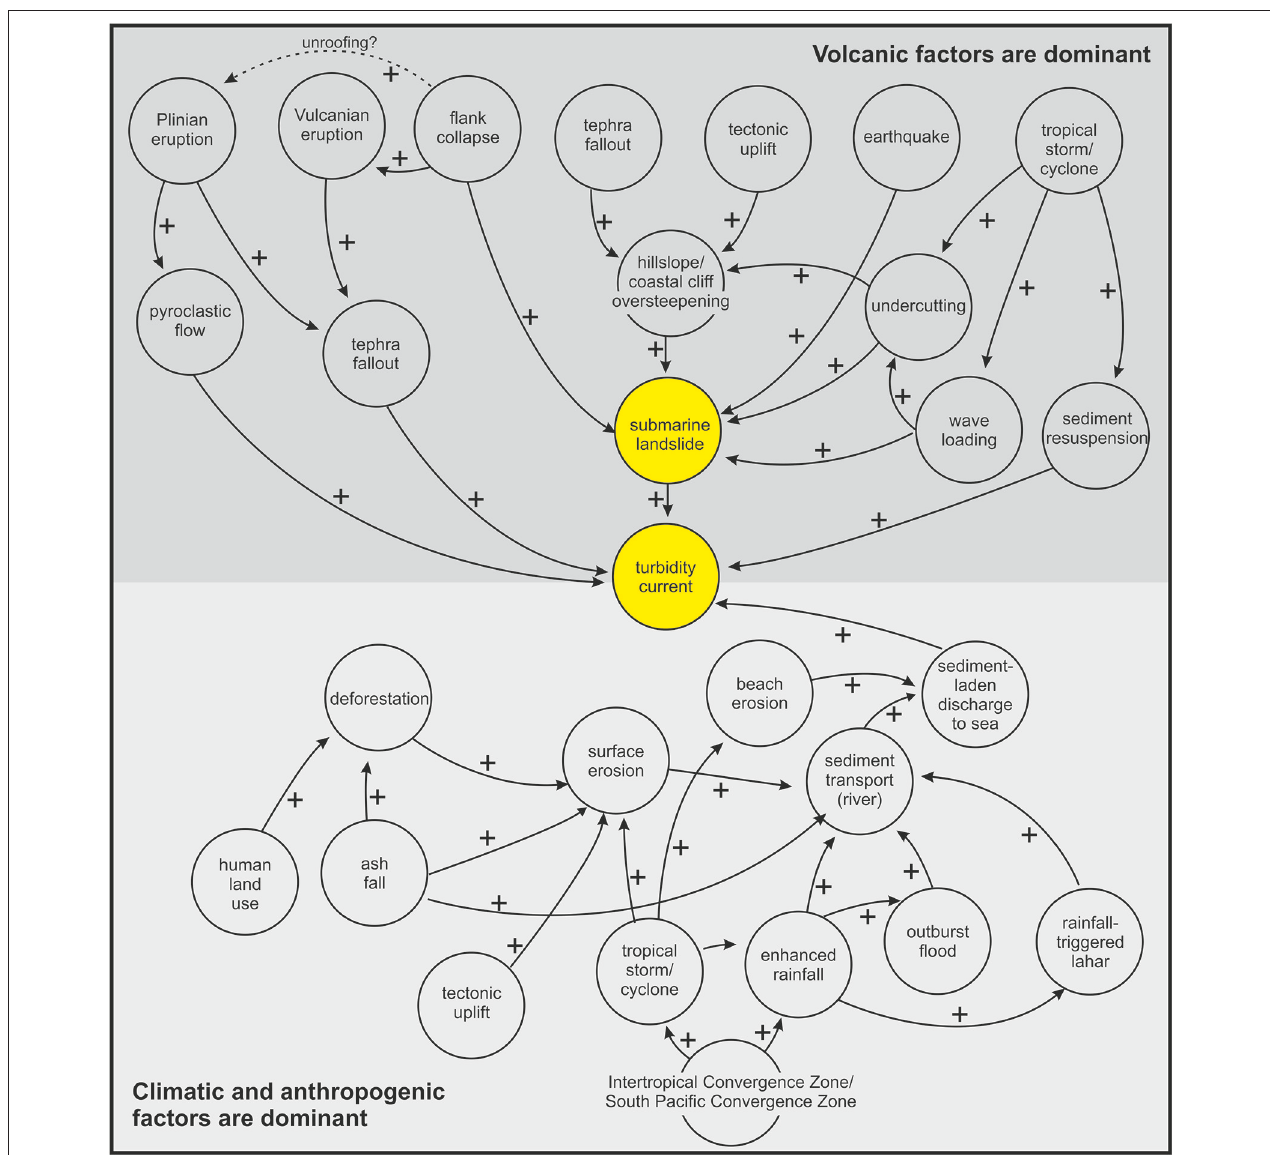
FIGURE 13 | Illustration of the potential complexity of interacting processes at volcanic islands that may precondition and trigger submarine landslides and turbidity currents. Plus signs and arrowed lines indicate how an increase in a variable may make a subsequent process more likely. Figure shows scenarios where volcanic factors may dominate (dark gray) and where climatic or anthropogenic factors may be more important (light gray). An animated version of this figure is available in the online material. Yellow circle refers to ultimately triggered event (landslide or turbidity